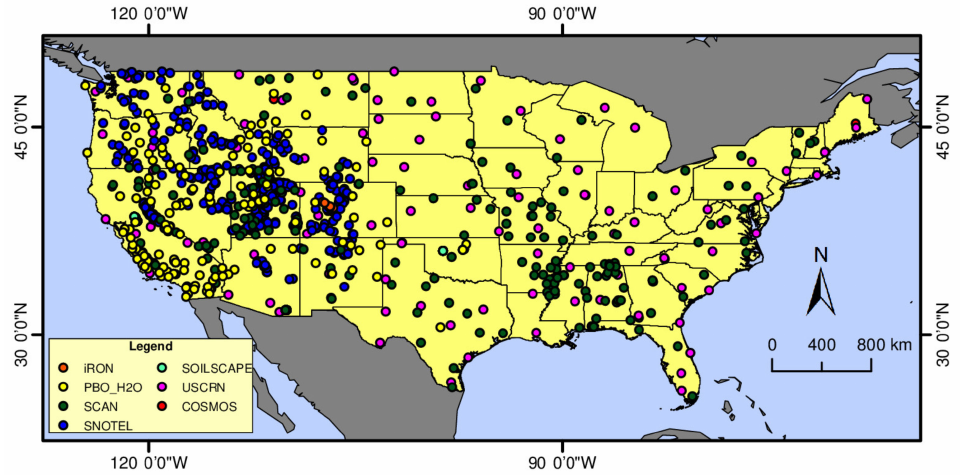
Figure 1. Study area and the spatial distribution of the in-situ